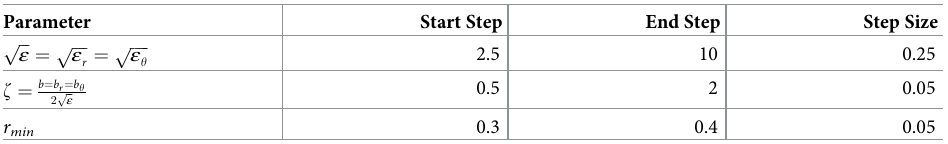
Table 1. Model parameters adjusted for